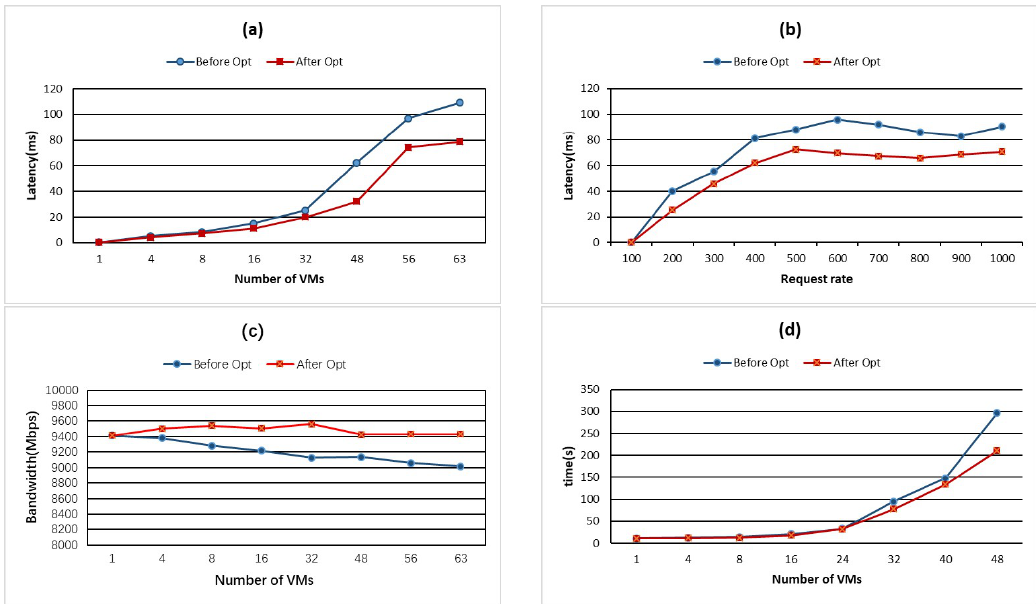
Figure 7. ( a ) Comparison of network delay when the request rate is fixed. ( b ) Comparison of network delay when the number of VMs is fixed. ( c ) Comparison of bandwidth throughput. ( d ) Comparison of file transfer